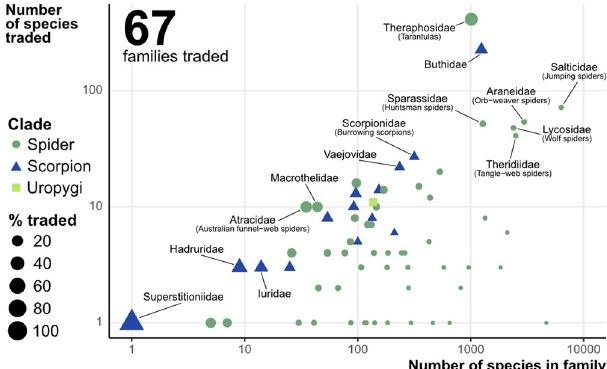
Fig. 2 Number of species plotted against the number of species traded. Each point represents one family, with some of the larger families named. Highlighted with text are some of the highest percentage traded families, with common names if applicable. n.b. log scales both x and y .